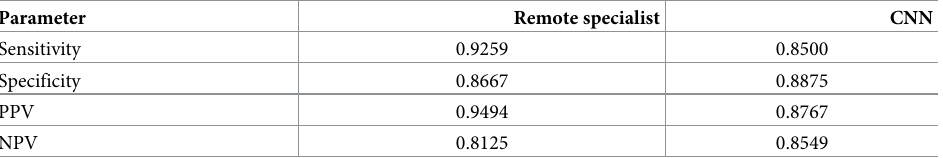
Table 4. Sensitivity, specificity, PPV, and NPV values for the images of sufficient quality for remote diagnosis and CNN evaluation compared to the gold-standard on-site specialist clinical